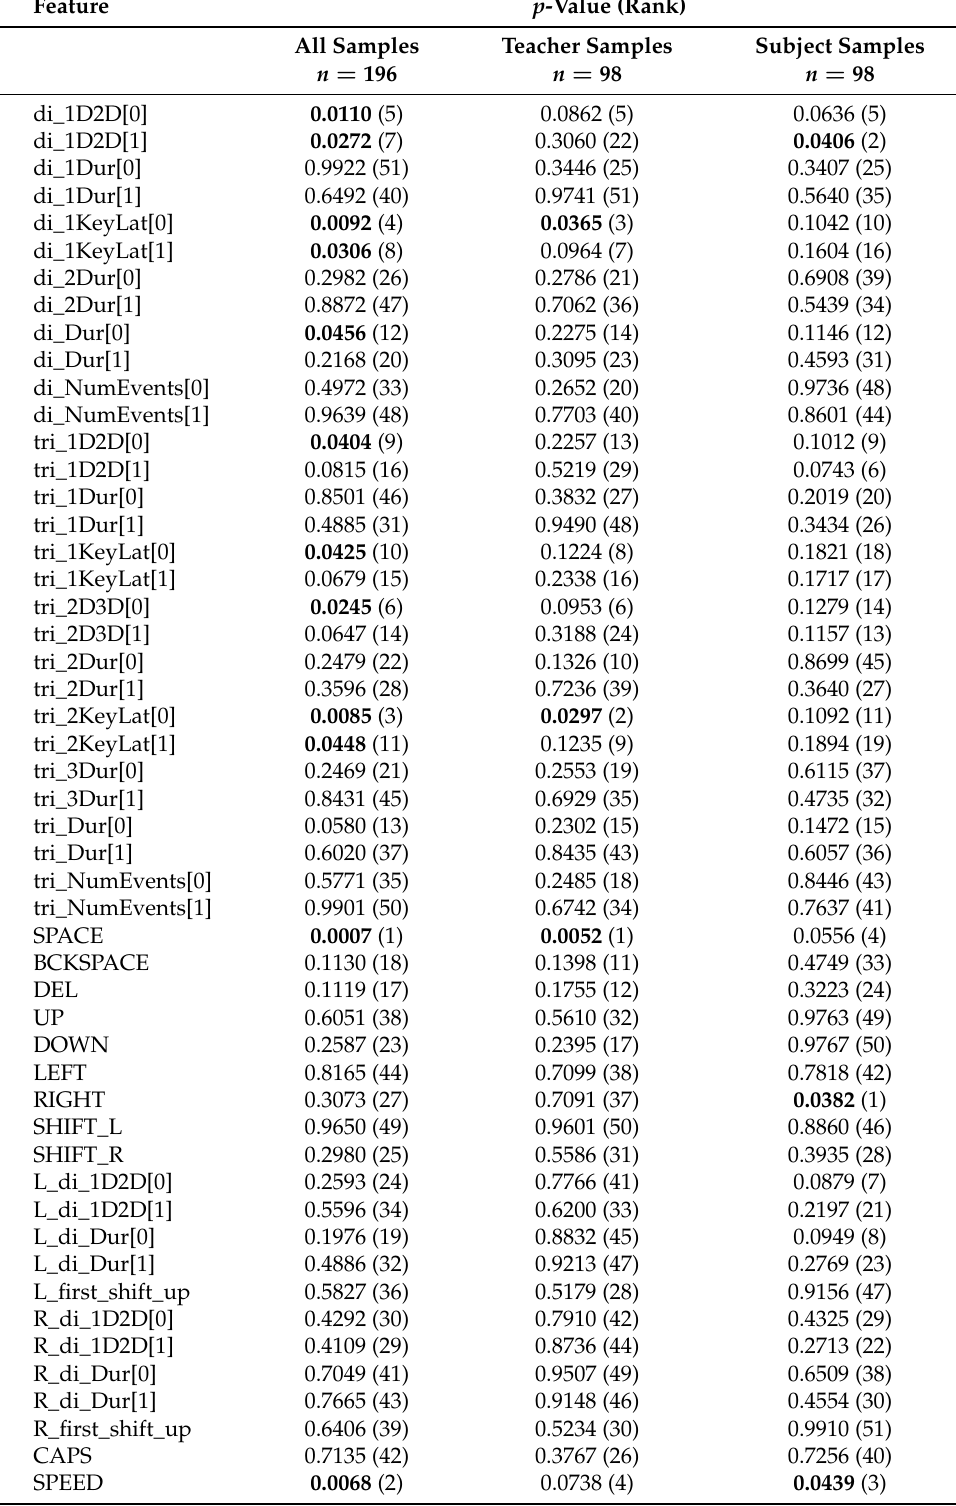
Table 4. Evaluation of keyboard patterns features—paired t -test results for positive/negative opinions, p -values below 0.05 are marked